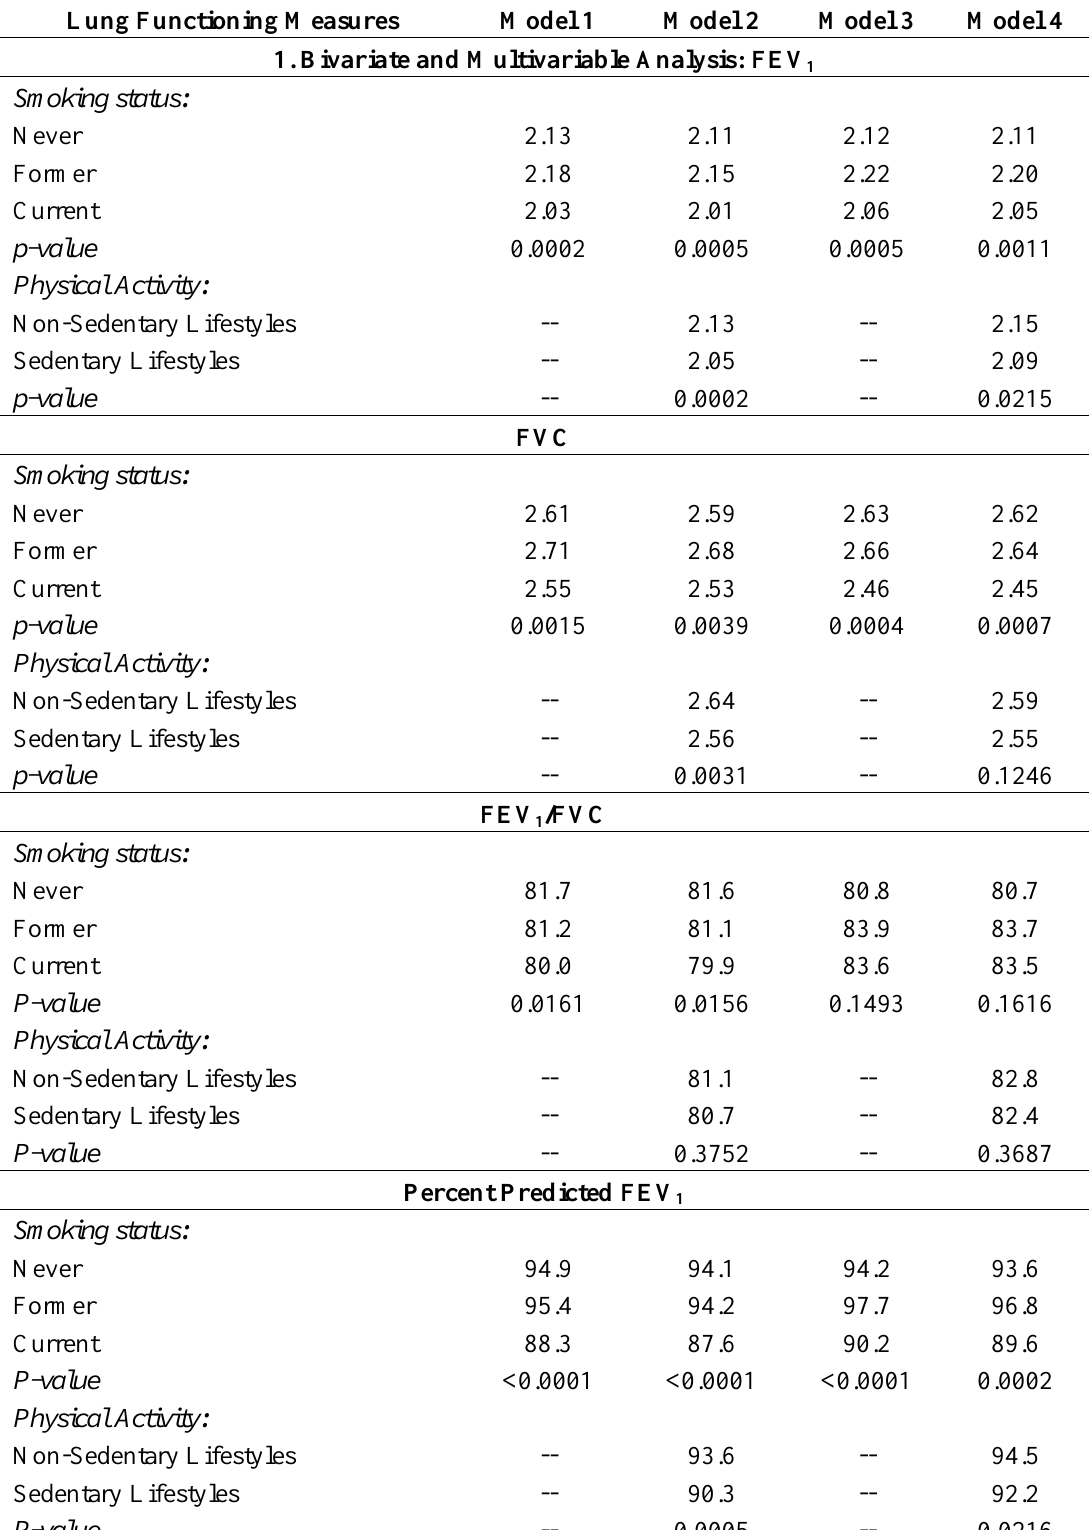
Table 3. Multivariate and Odds Ratio test of mediation of sedentary lifestyle on the association of smoking status and lung function among African American